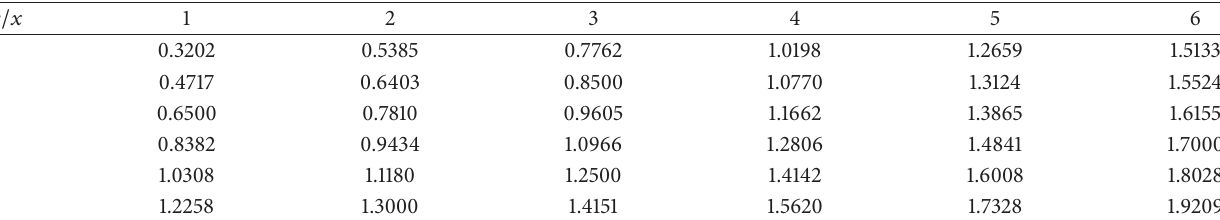
Table 5: A 3D monotone data set.